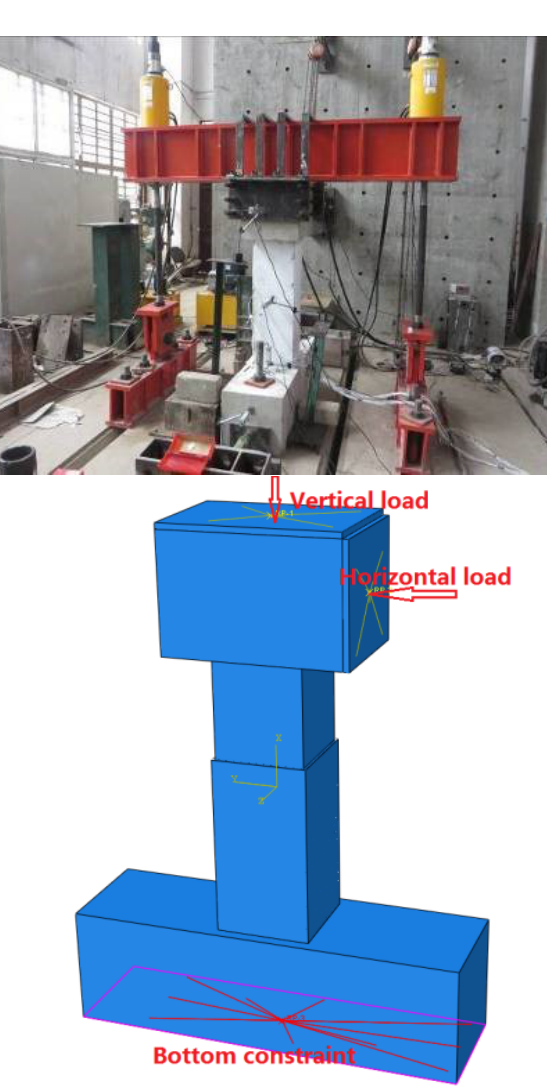
and energy dissipation capacity of the specimens increase with the decrease of stirrup spacing.